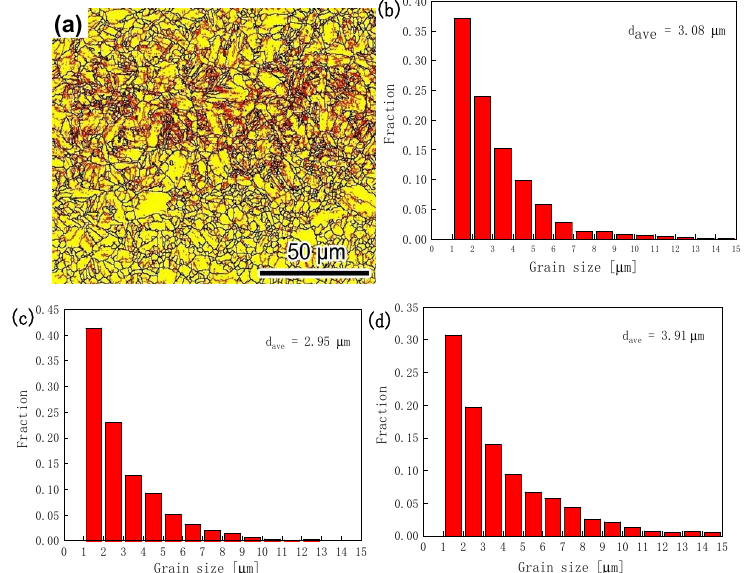
Figure 9. ( a ) EBSD images of grain size for hot-formed parts from the side position with high angle boundaries >10 ◦ ; grain size distribution of the martensite ferrite for hot-formed parts in different positions: ( b ) top; ( c ) side; and( d ) bottom.